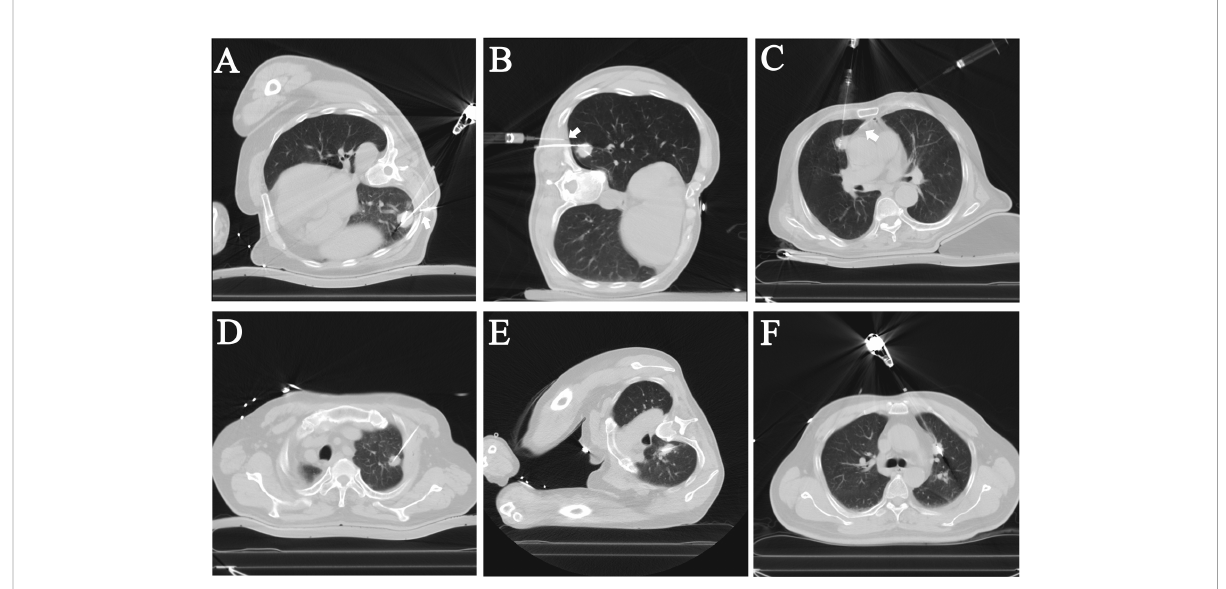
FIGURE 1 Intraoperative CT images of patients who underwent local pleural anesthesia (LPA) or not during the microwave ablation (MWA) procedures. (A – C) In the LPA group, the needle and syringe used for local pleural anesthesia can be seen on the CT images. The tips of the anesthesia needles (Arrows) were visualized on the CT as reaching the subpleural and used to administer the anesthesia. (D – F) The NLPA group ’ s ablation antennas were located in the center of the nodules without local pleural anesthesia.